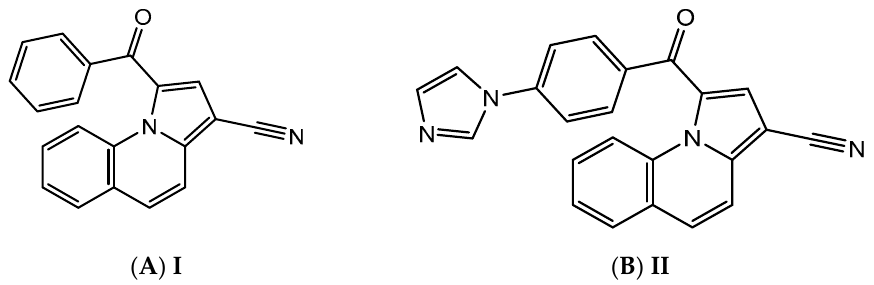
Figure 1 . ( A )Structures of 1-benzoyl-3-cyanopyrrolo[1,2- a ] quinolines ( I ), and ( B )1-(4-(1- h